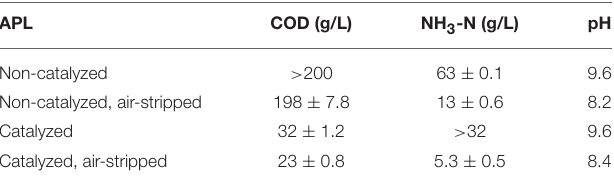
TABLE 2 | COD and NH 3 -N concentrations and pH in non-catalyzed and catalyzed APL with and without air stripping. APL COD